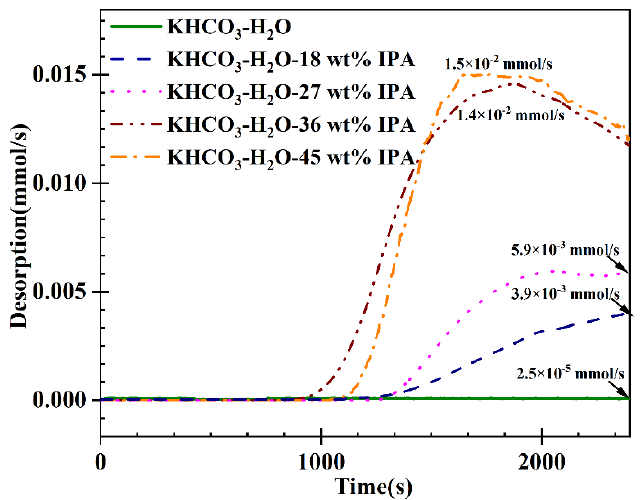
Figure 6. CO 2 desorption rates in KHCO 3 − H 2 O and KHCO 3 − H 2 O − IPA solutions.